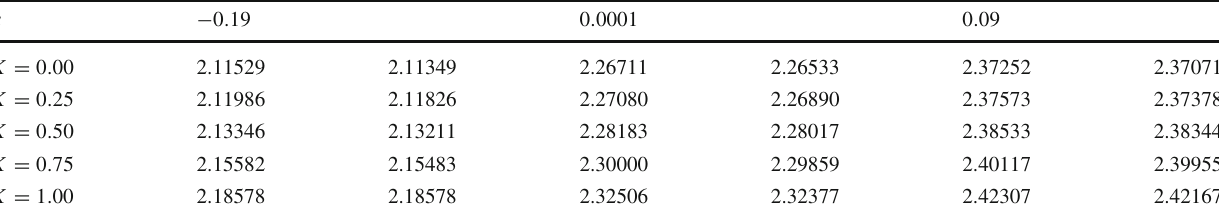
Table 2 The critical chemical potential (cid:12) c = q μ c / r s obtained by the analytical S–L method (left column) and numerical computation (right column) for the holographic p-wave superfluid model for different val-